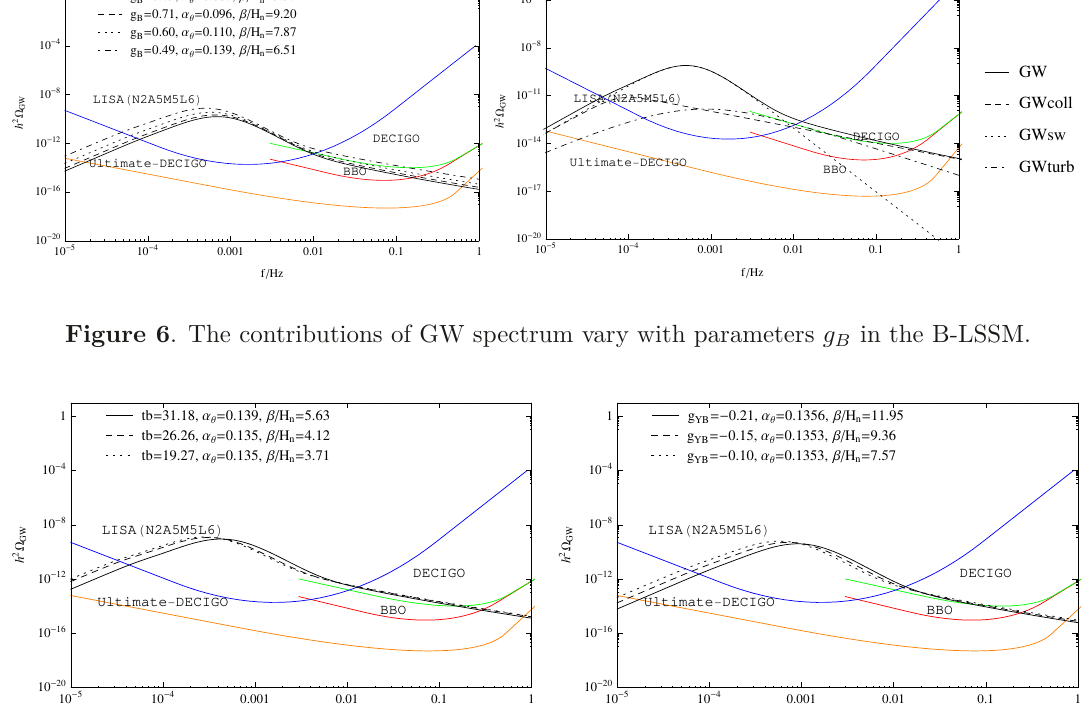
Figure 7 . The contributions of GW spectrum vary with parameters tb and g Y B in the B-LSSM. dashed, dotted and dot dashed lines. The contributions of GW spectrum, coming